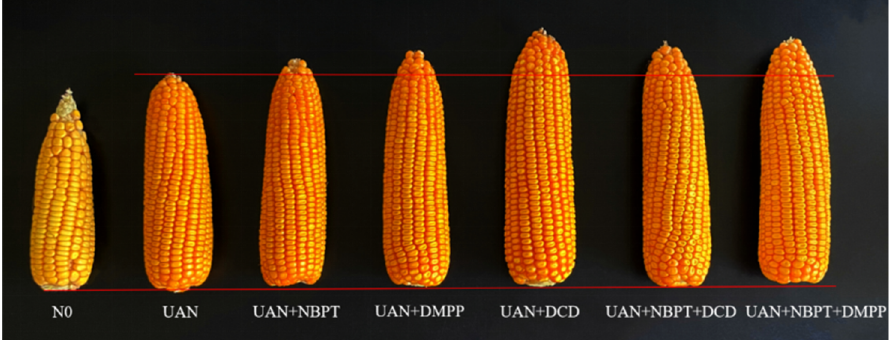
Figure 1. Morphological effect of UAN and inhibitors on maize ear.